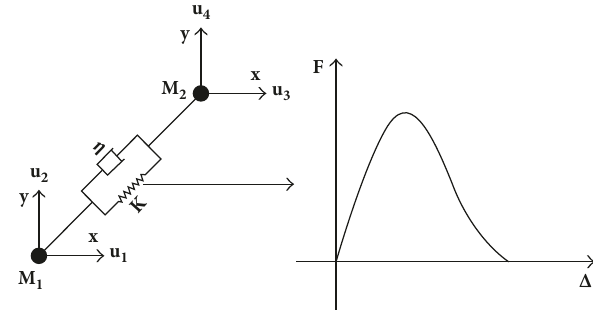
Figure 2: Hyperelastic-Kelvin